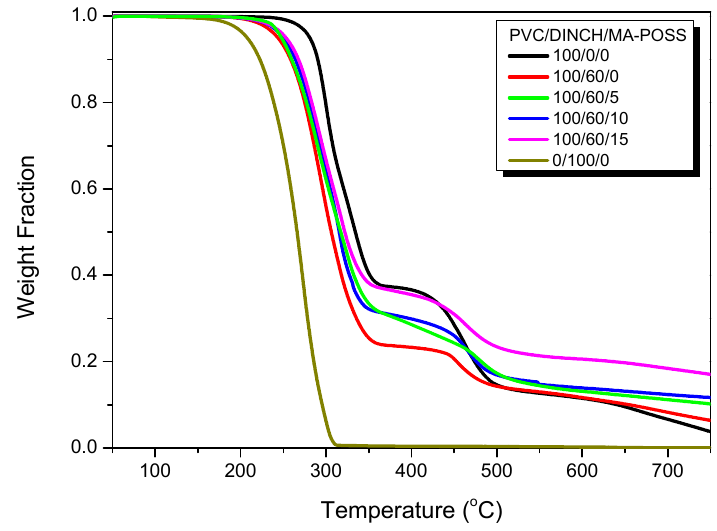
Figure 7. TGA analyses of PVC/DINCH/MA-POSS blends of various compositions.